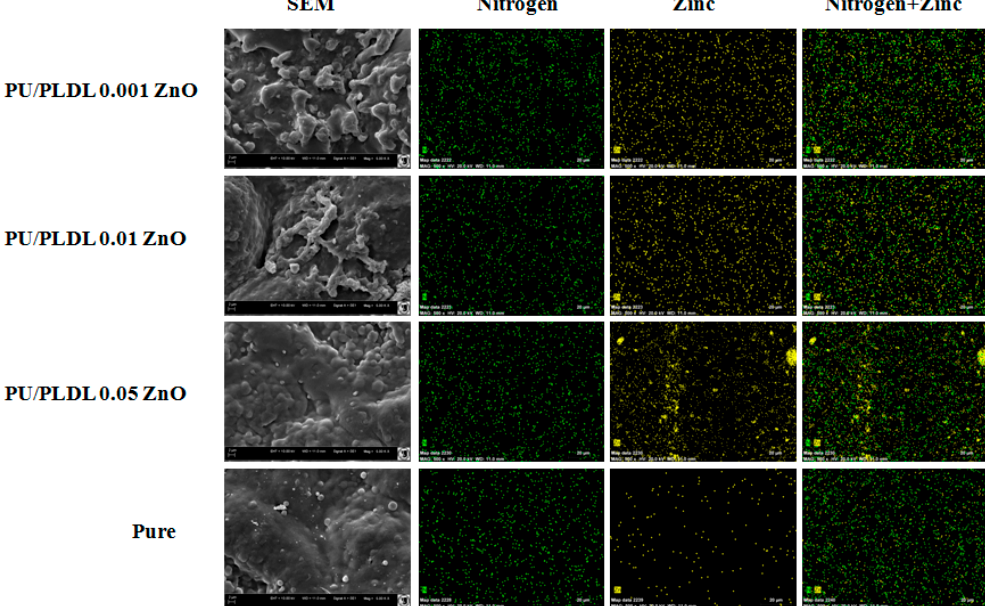
Figure 2. SEM EDX mapping images (nitrogen—green, zinc—yellow) of PU/PLDL/ZnO composites and pure PU/PLDL blend; magnifications 5000× for SEM, 500x for EDX mapping.